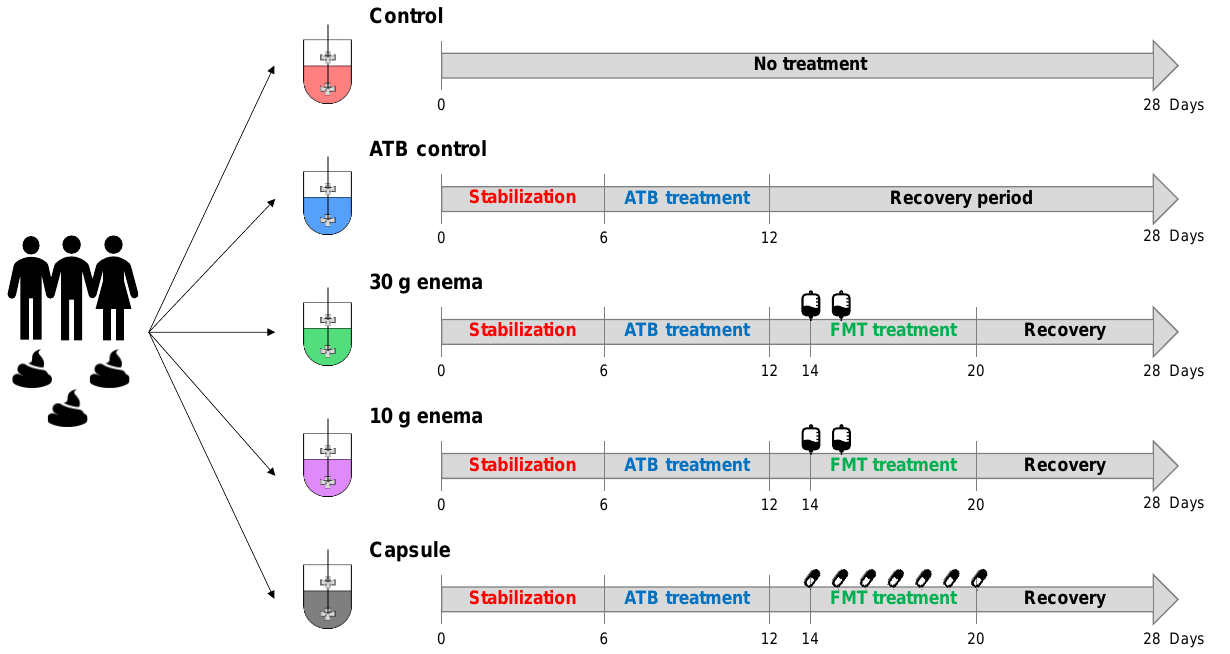
Figure 1. Experimental design of in vitro fermentations in ARtificial COLon (ARCOL) system.